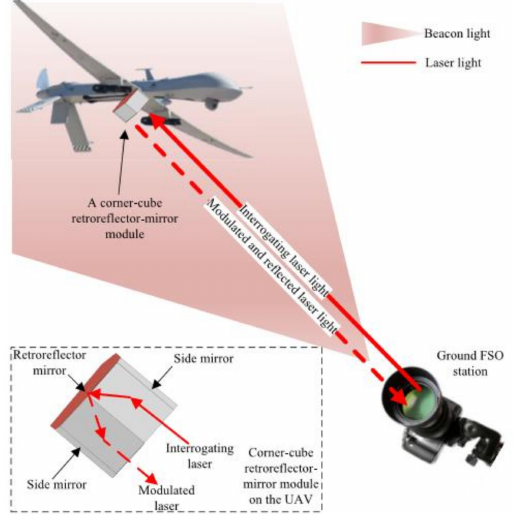
Figure 13. Conceptual illustration of the hybrid ATP mechanism on the ground and a retroreflector mirror mounted onto the UAV to modulate and reflect back an interrogating laser